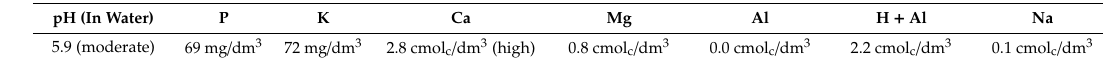
Table 10. Physicochemical characteristics of soil samples.